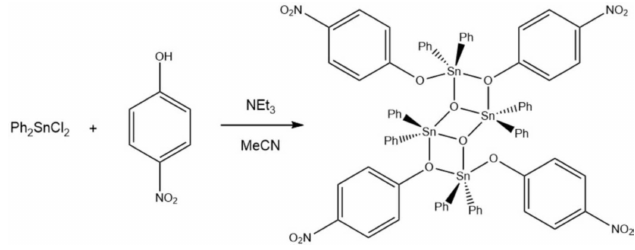
Figure 4 The reaction scheme for the synthesis of the title